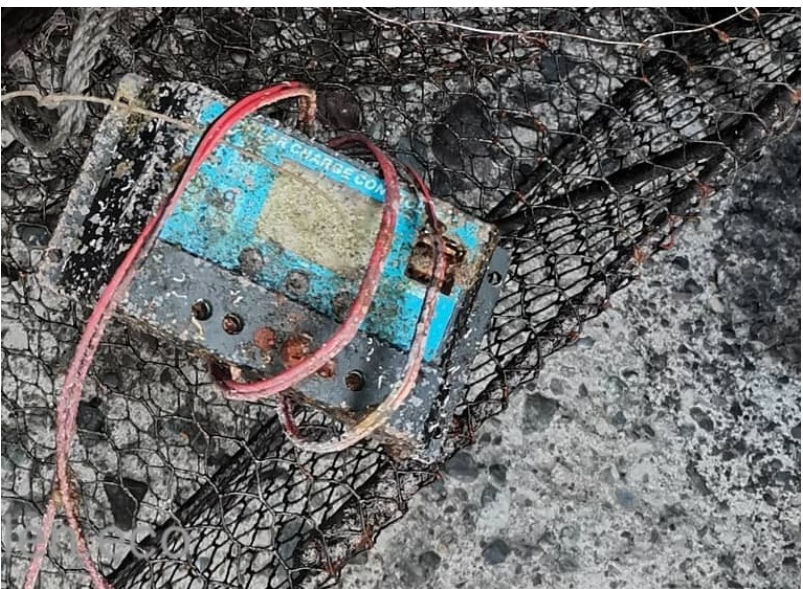
Figure 4. Solar power charging connector recovered via underwater retrieval in Los Abrigos, Tenerife.